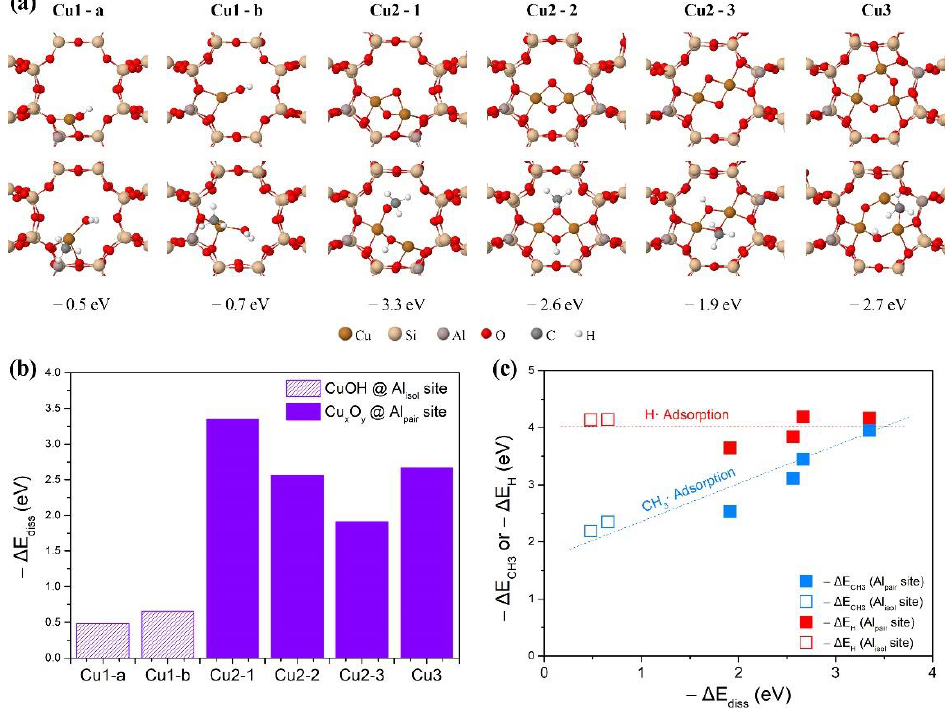
Figure 5. ( a ) DFT-derived structures of the original Cu-oxo species grafted at the 8-MR of MOR (above) and the corresponding structures after the dissociation of CH 4 onto the Cu-oxo species (below); ( b ) Calculated CH 4 dissociation energies (Δ E diss ) for the Cu-oxo clusters bound to the Al pair sites and the CuOH species bound to the isolated Al sites; ( c ) Correlation of the CH 4 dissociative adsorption energy (Δ E diss ) with the adsorption energies for the CH 3 · (Δ E CH3*, blue squares) and H· (Δ E H* , red squares) groups.